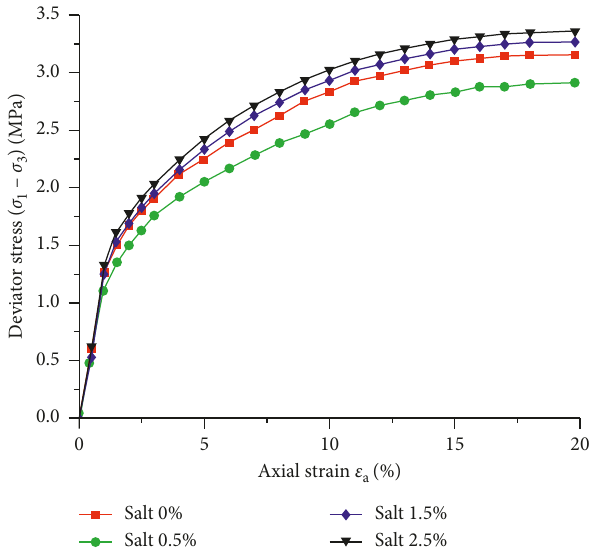
Figure 2: The typical stress-strain curves of frozen saline silty clay with different salt contents under a confining pressure of